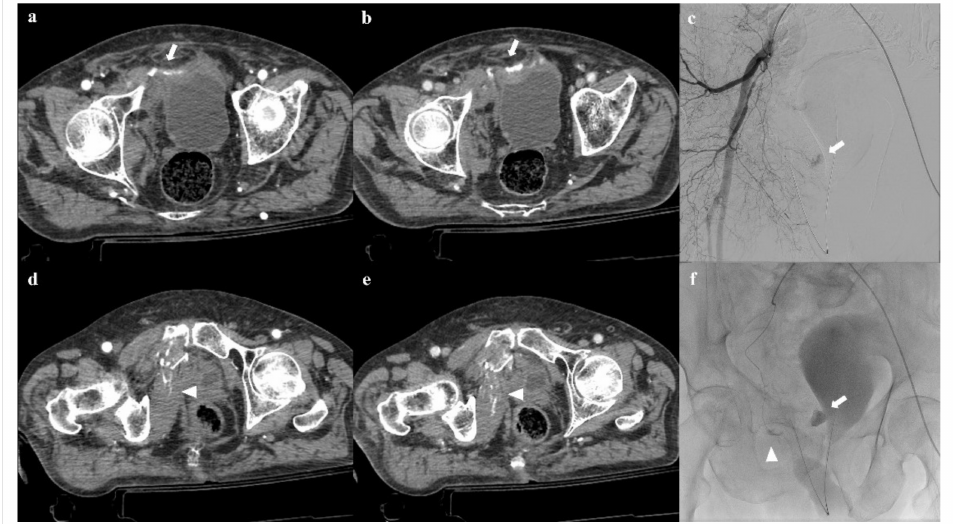
Figure 10. Pelvic ring trauma, characterized by fracture of right superior and inferior pubic rami. Axial CT image in the arterial phase shows active extravasation of contrast medium near the right superior pubic branch (arrow in ( a )), which increases in the venous phase of the examination (arrow in ( b )). Similar active extravasation is documented near the internal obturator muscle (arrowheads in ( d , e )). Selective angiography confirmed the two blood extravasation spots, with origin from branches of the right obturator artery (arrows and arrowhead in ( c , f )); both the bleeding spots were optimally